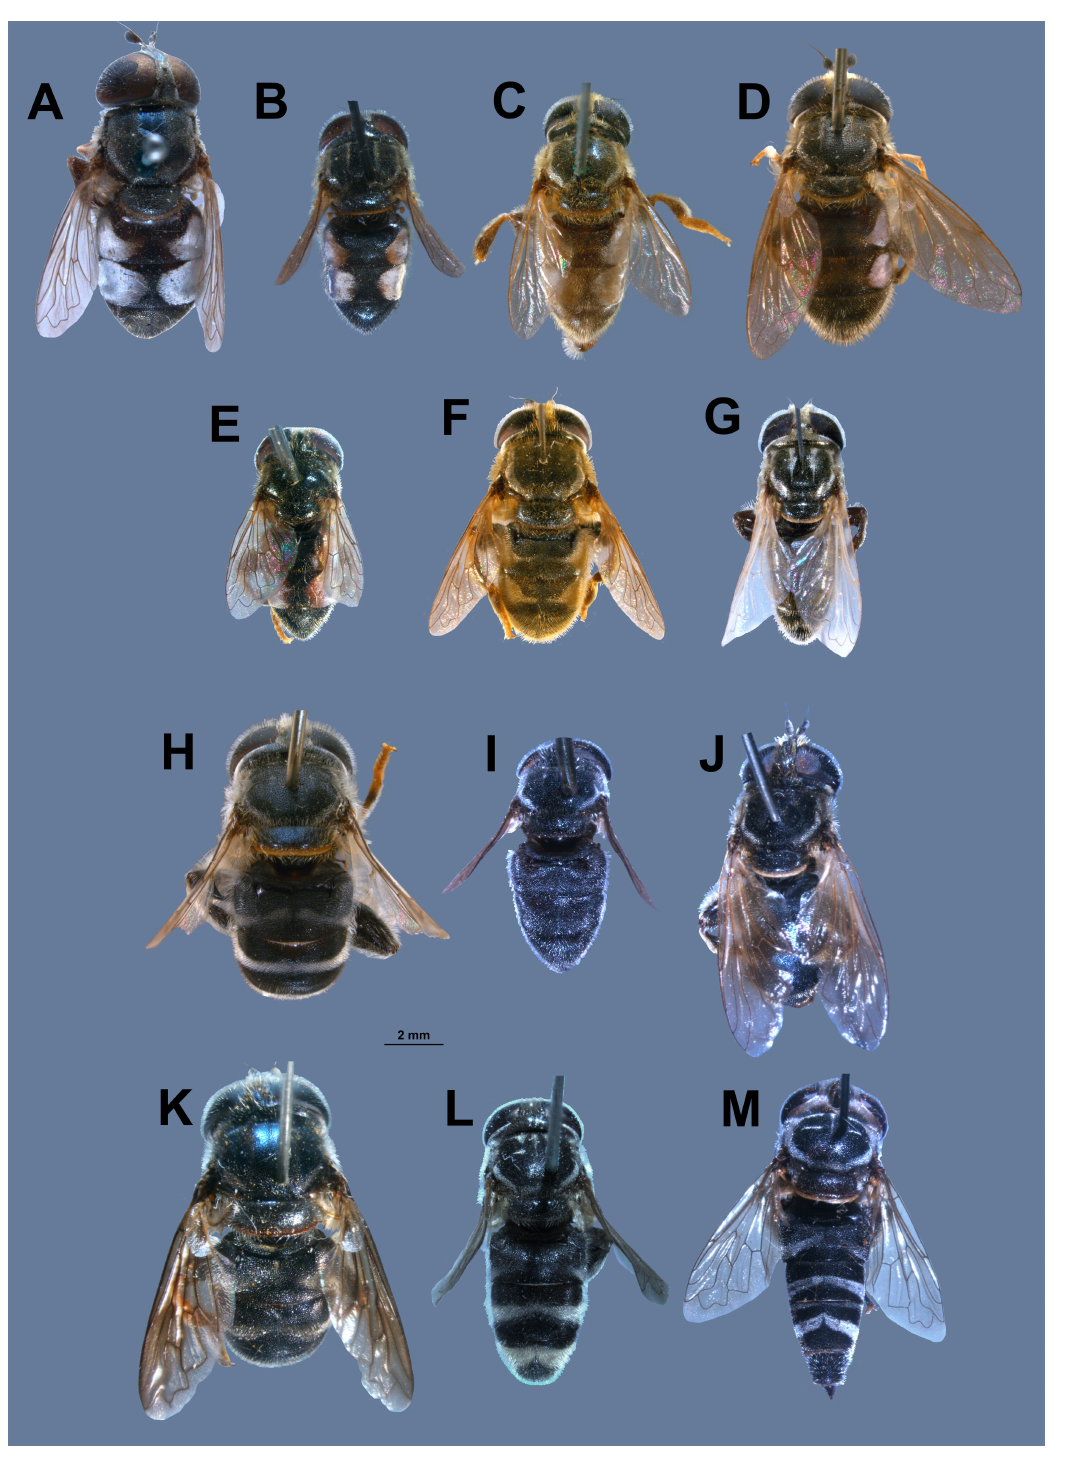
Fig. 1. Megatrigon spp., habitus, dorsal view. A . Megatrigon argenteus (Walker, 1852) comb. nov. (♂). B . M. argentifrons sp. nov. (♂). C . M. argentimaculatus sp. nov. (♂). D . M. magnicornis sp. nov. (♂). E . M. natalensis sp. nov. (♂). F . M. sexmaculatus sp. nov. (♂). G . M. apiformis sp. nov. (♂) . H . M. cooksoni sp. nov. (♂). I . M. immaculatus sp. nov. (♂). J . M. ochreatus (Hull, 1964) comb. nov. (♂). K . M. tabanoides sp. nov. (♂). L . M. jacobi (Hervé-Bazin, 1913) comb. nov. (♂). M . M. nivalis (Hull, 1964) comb. nov.